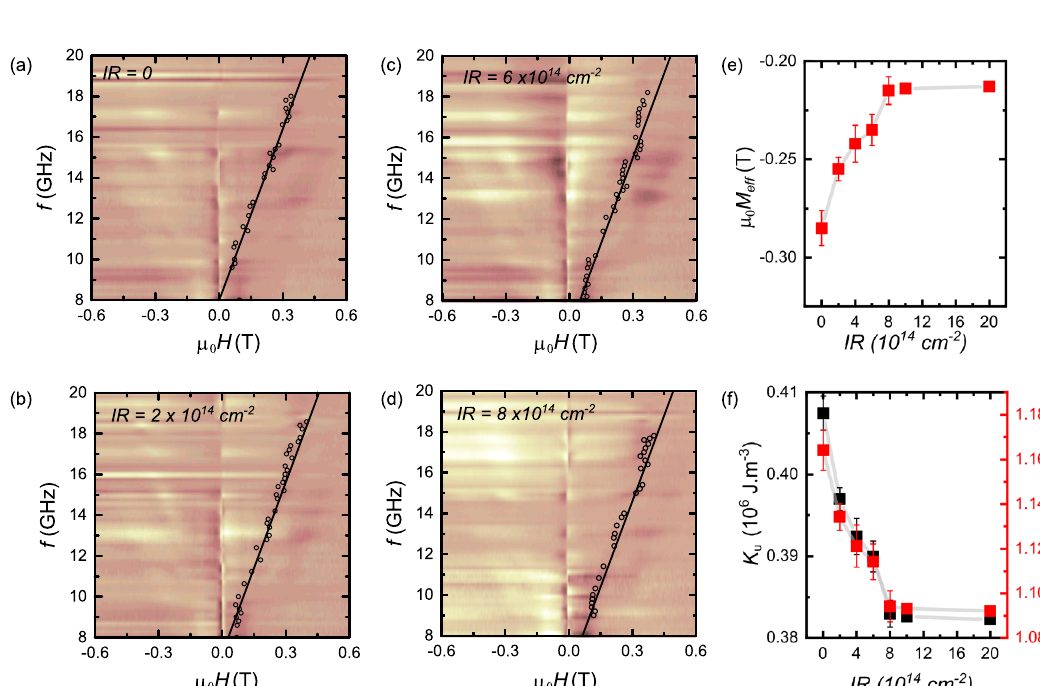
Figure 3. ( a – d ) Microwave transmission as a function of frequency for different IR with the magnetic field perpendicular to the film plane. The black hollow markers depict the resonance field obtained by fitting FMR spectra using the Eq. S1 and solid lines are fitting curve. ( e , f ) The effective magnetisation µ 0 M eff (e) and the effective uniaxial anisotropy field µ 0 H K ( f ) as a function of measured anisotropy constant K u includes both the first-order K u1 and the second-order K u2 contributions, as